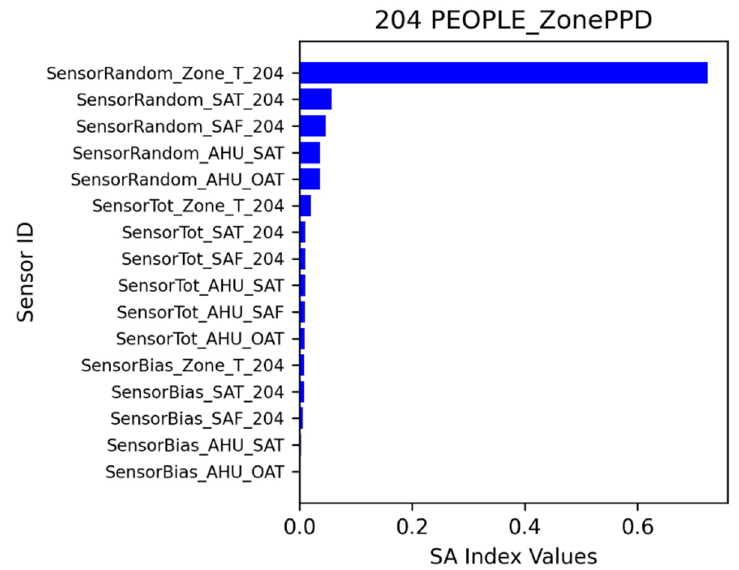
Figure 24. SA for zone 204 PPD.